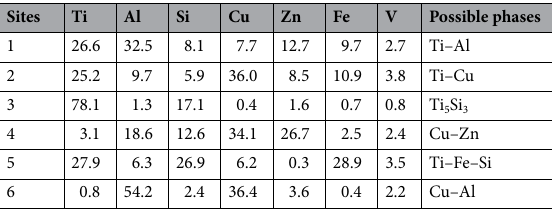
Table 5. EDS results (in at.%) on both sides of the joint materials in Fig. 6.